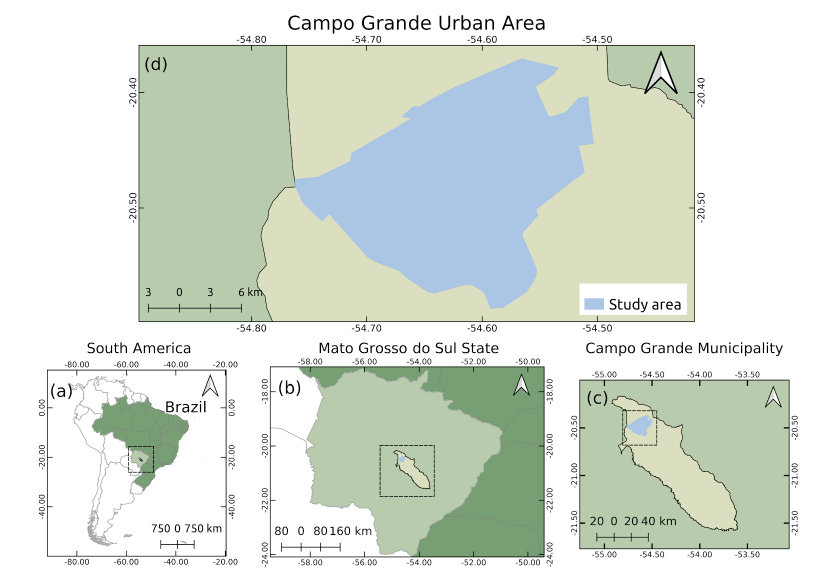
Figure 2. Study area location: ( a ) South America and Brazil; ( b ) Mato Grosso do Sul; ( c ) Campo Grande; and ( d ) Study